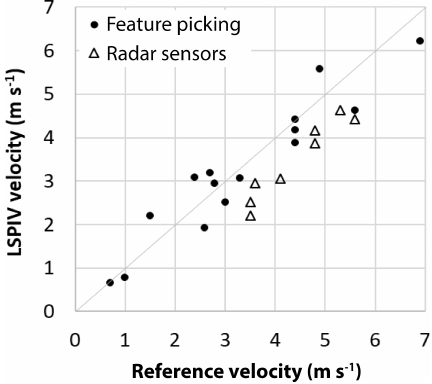
Figure 5. LSPIV velocities compared with velocities derived from feature picking in the orthorectified image sequences and radar sen- sors located 70–150m